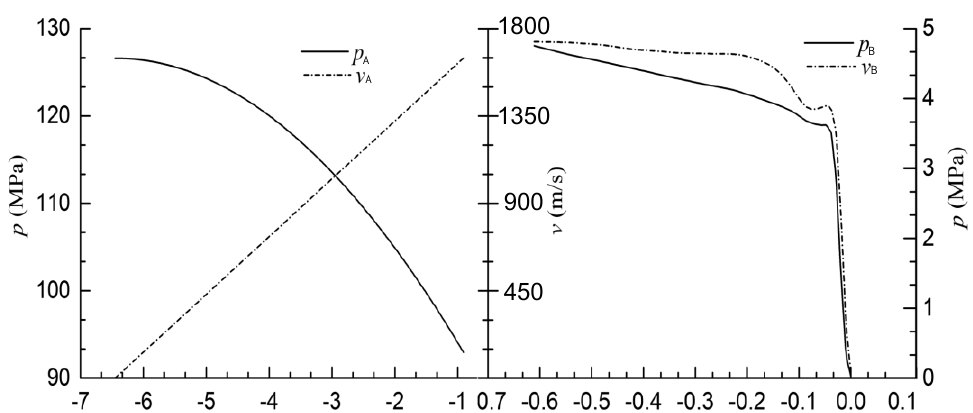
Figure 4. Velocity and pressure distribution inside the barrel at the initial moment.